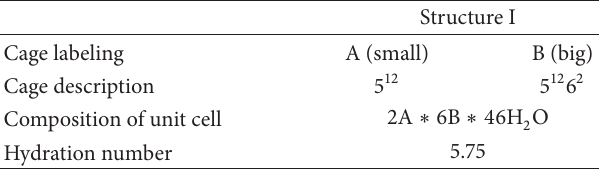
Table 1: Properties of hydrate structure I (s I).